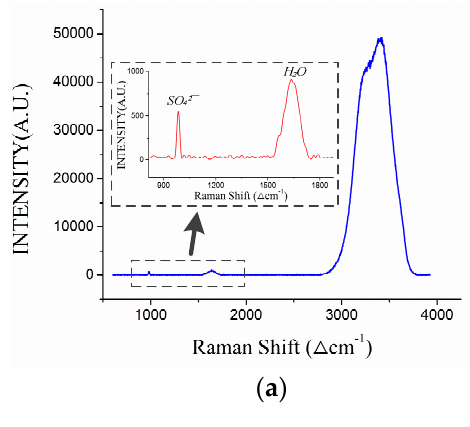
Table 1. Information of profile measurement process.